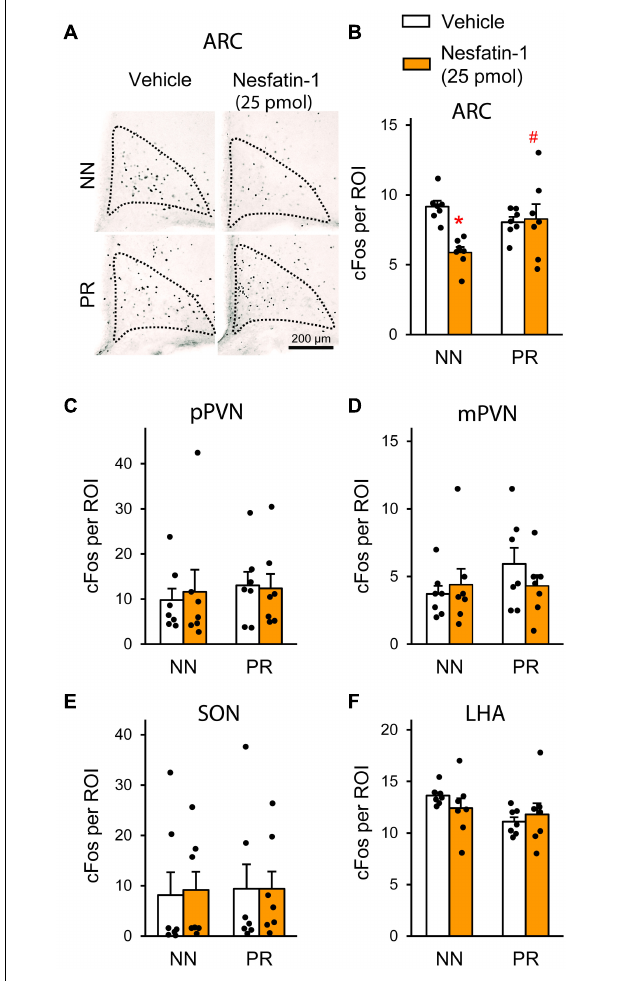
FIGURE 5 | Neuronal activation (cFos) in the hypothalamus following acute icv nesfatin-1 injection (25 pmol) into NN and PR rats subjected to overnight fasting. (A) Representative light microscopic images showing cFos-immunoreactive cell nuclei (black dots) mainly within the medial ARC of the different experimental groups. (B–F) Bar graphs showing the quantitative data on the number of cFos-positive cells per region of interest (ROI). (B) ARC. Nesfatin-1 reduced the number of fasting activated neurons in the NN rats. Two-way ANOVA, effect of treatment: F ( 1 , 24 ) = 5.743, p = 0.025; treatment × phenotype: F ( 1 , 24 ) = 7.671, p = 0.011. Tukey multiple comparison test, * p < 0.05 vs. NN-vehicle; # p < 0.05 vs. NN-nesfatin-1. (C) Parvocellular PVN (pPVN). (D) Magnocellular PVN (mPVN). (E) SON. (F) LHA. Two-way ANOVA, Means ± SEM, n =